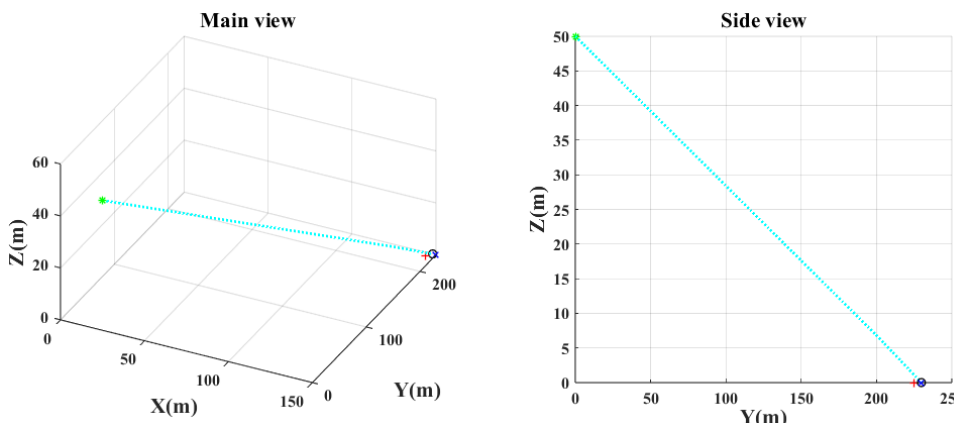
Figure 15. The ballistic of GD in case 2.